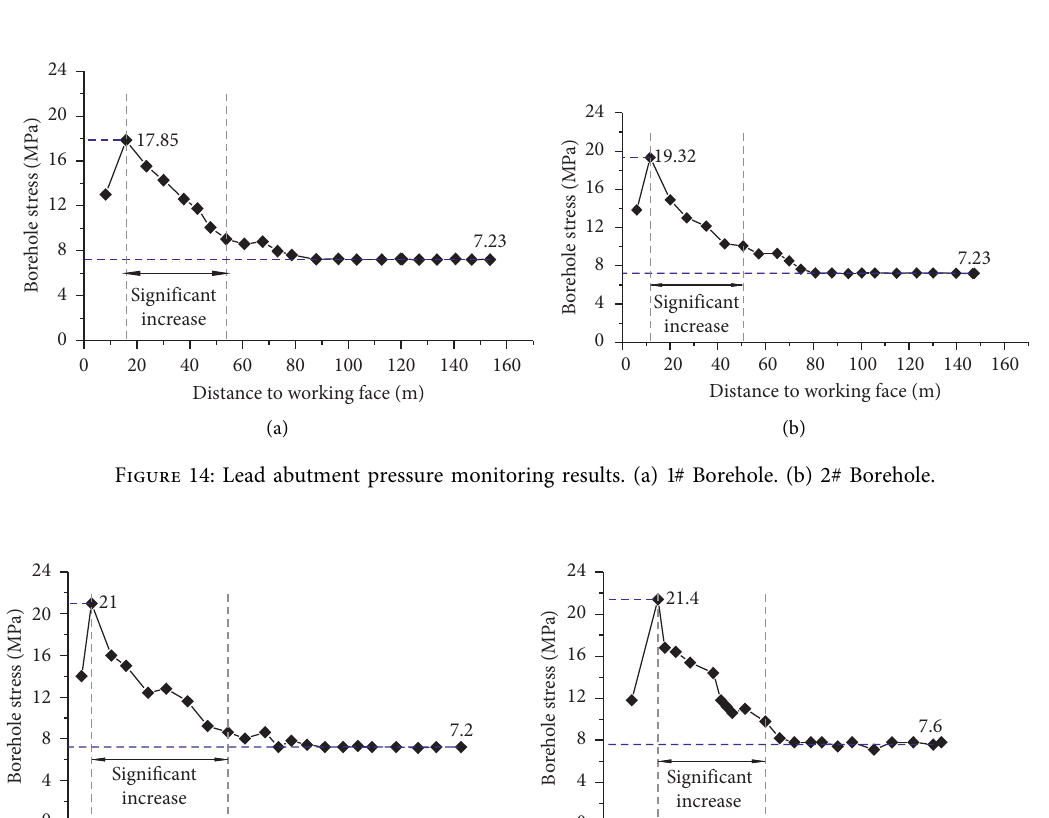
Figure 13: Schematic diagram of the station layout.